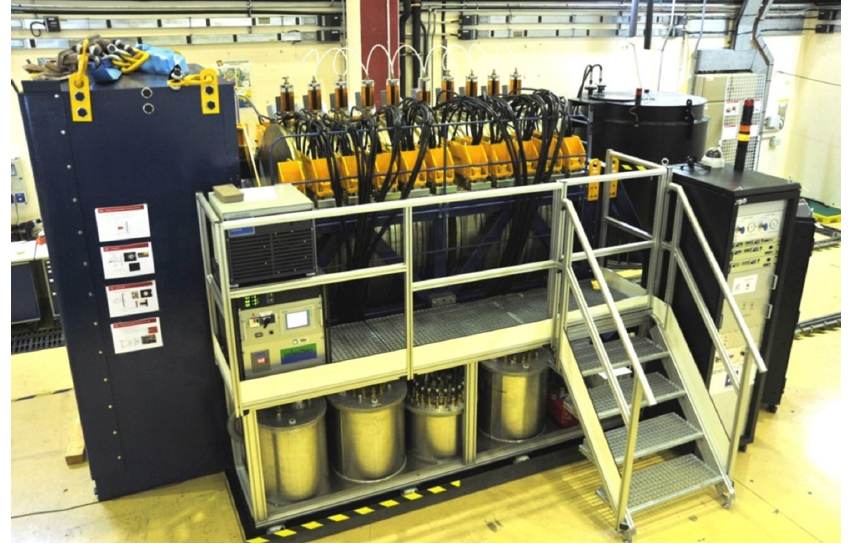
FIG. 1. Overall view of the 1 MV driver composed of ten stacked cavities in series.